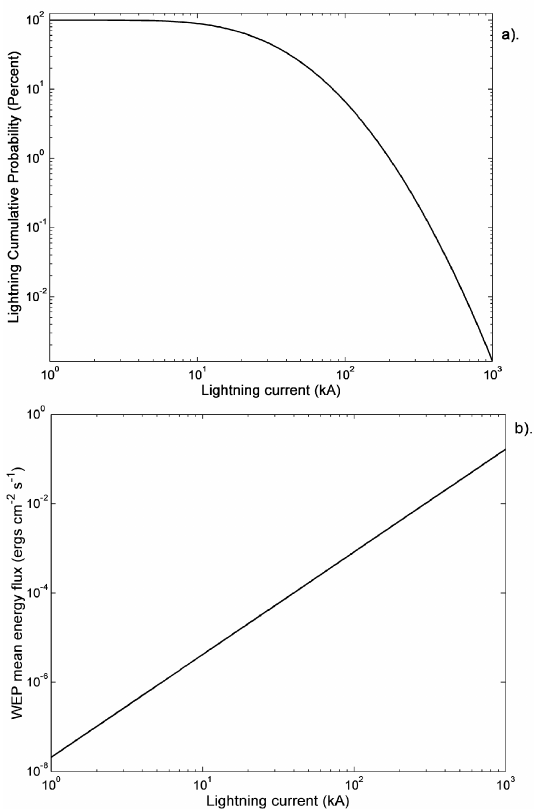
Fig. 6. (Top panel) Cumulative statistical distribution for CG light- ning return stroke peak currents. (Lower panel) Magnitude of the WEP mean energy precipitation flux expected from a given light- ning return stroke peak